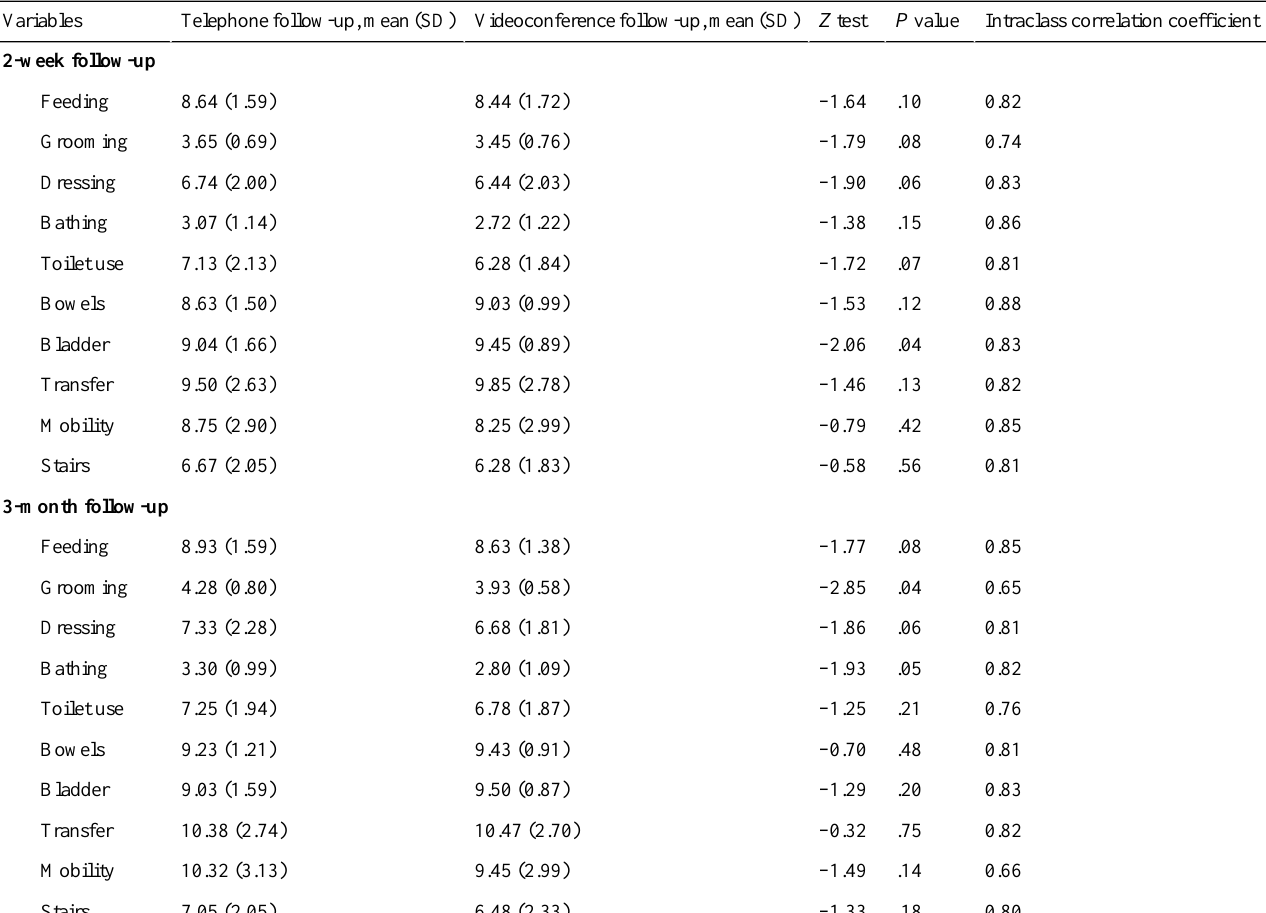
Table 2. Comparison of Modified Barthel Index scores evaluated by videoconference and telephone follow-up assessments at 2-week follow-up and 3-month follow-up.